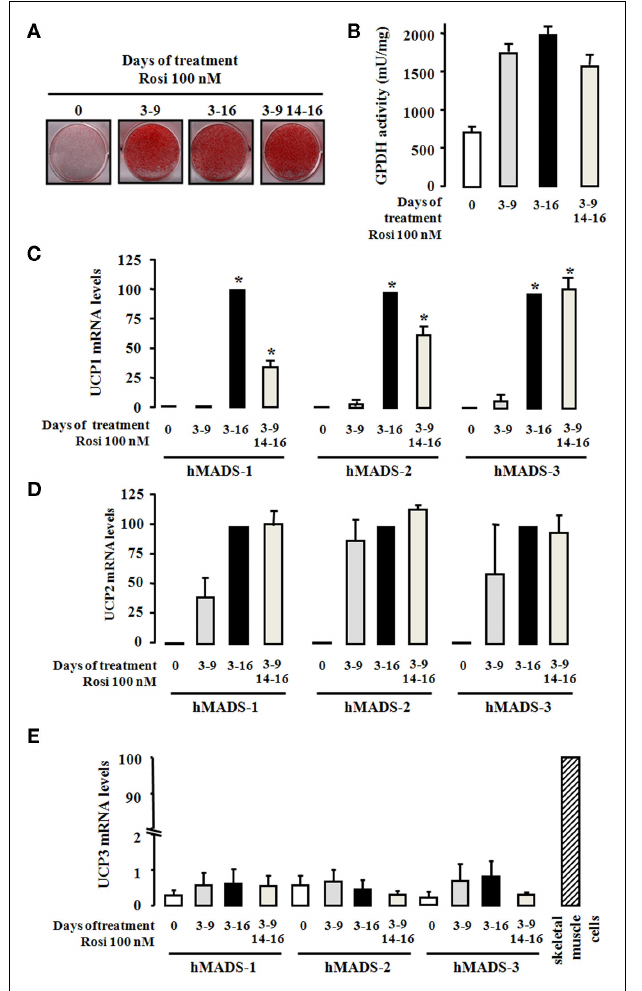
FIGURE 1 | Conversion of hMADS cells into brown- like adipocytes. hMADS-1, 2, and 3 cells were induced to differentiate into adipocytes as described under the Section “Materials and Methods.” Hundred nanometer rosiglitazone was added during the indicated periods of treatment. At day 16, (A) cells were fixed and stained by Oil Red O, (B) GPDH activity was determined, and (C–E) UCP1, UCP2, and UCP3 mRNA levels, respectively, were measured by quantitative RT-PCR. Results are mean ± SEM of three (B,C) or two (D,E) independent experiments. Results in (C) and (D) are expressed by taking as 100% the value obtained for rosiglitazone treatment between days 3 and 16. In (E) , human skeletal muscle cells were used as positive control for UCP3 expression. Results in (E) are expressed taking as 100% the value obtained for skeletal muscle cells. * p < 0.05 vs. cells treated between days 3 and 9.